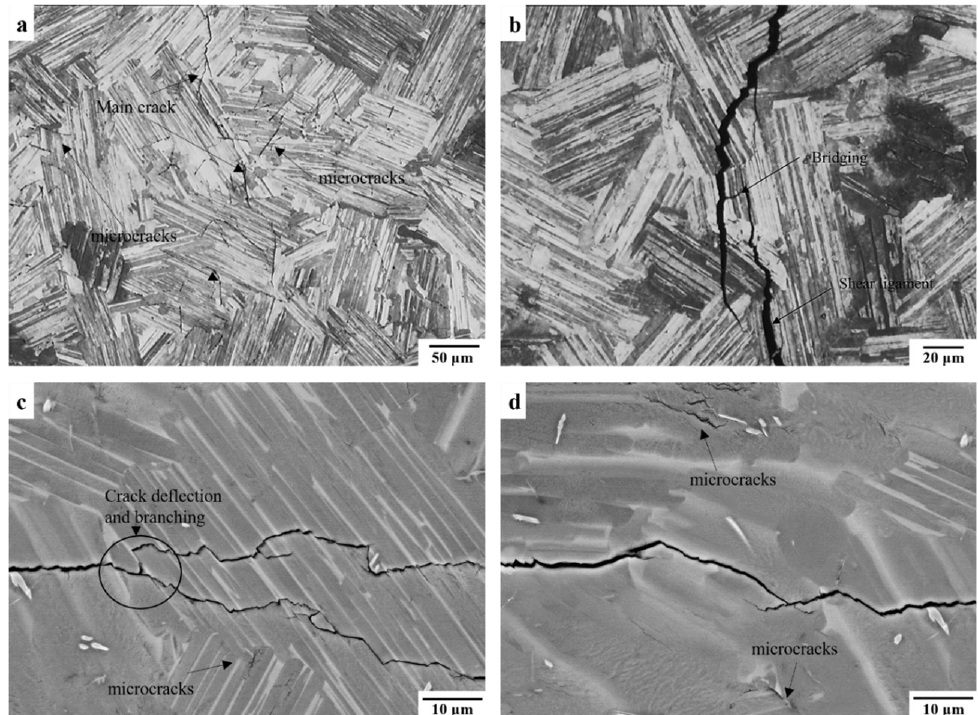
Figure 10. Toughening mechanisms were found in ( a , b ) SENB specimens and ( c , d ) CC specimens, including microcrack shielding, bridging by shear ligaments, crack deflection, and branching. Both specimens were tested at RT with an R ratio of 0.1.